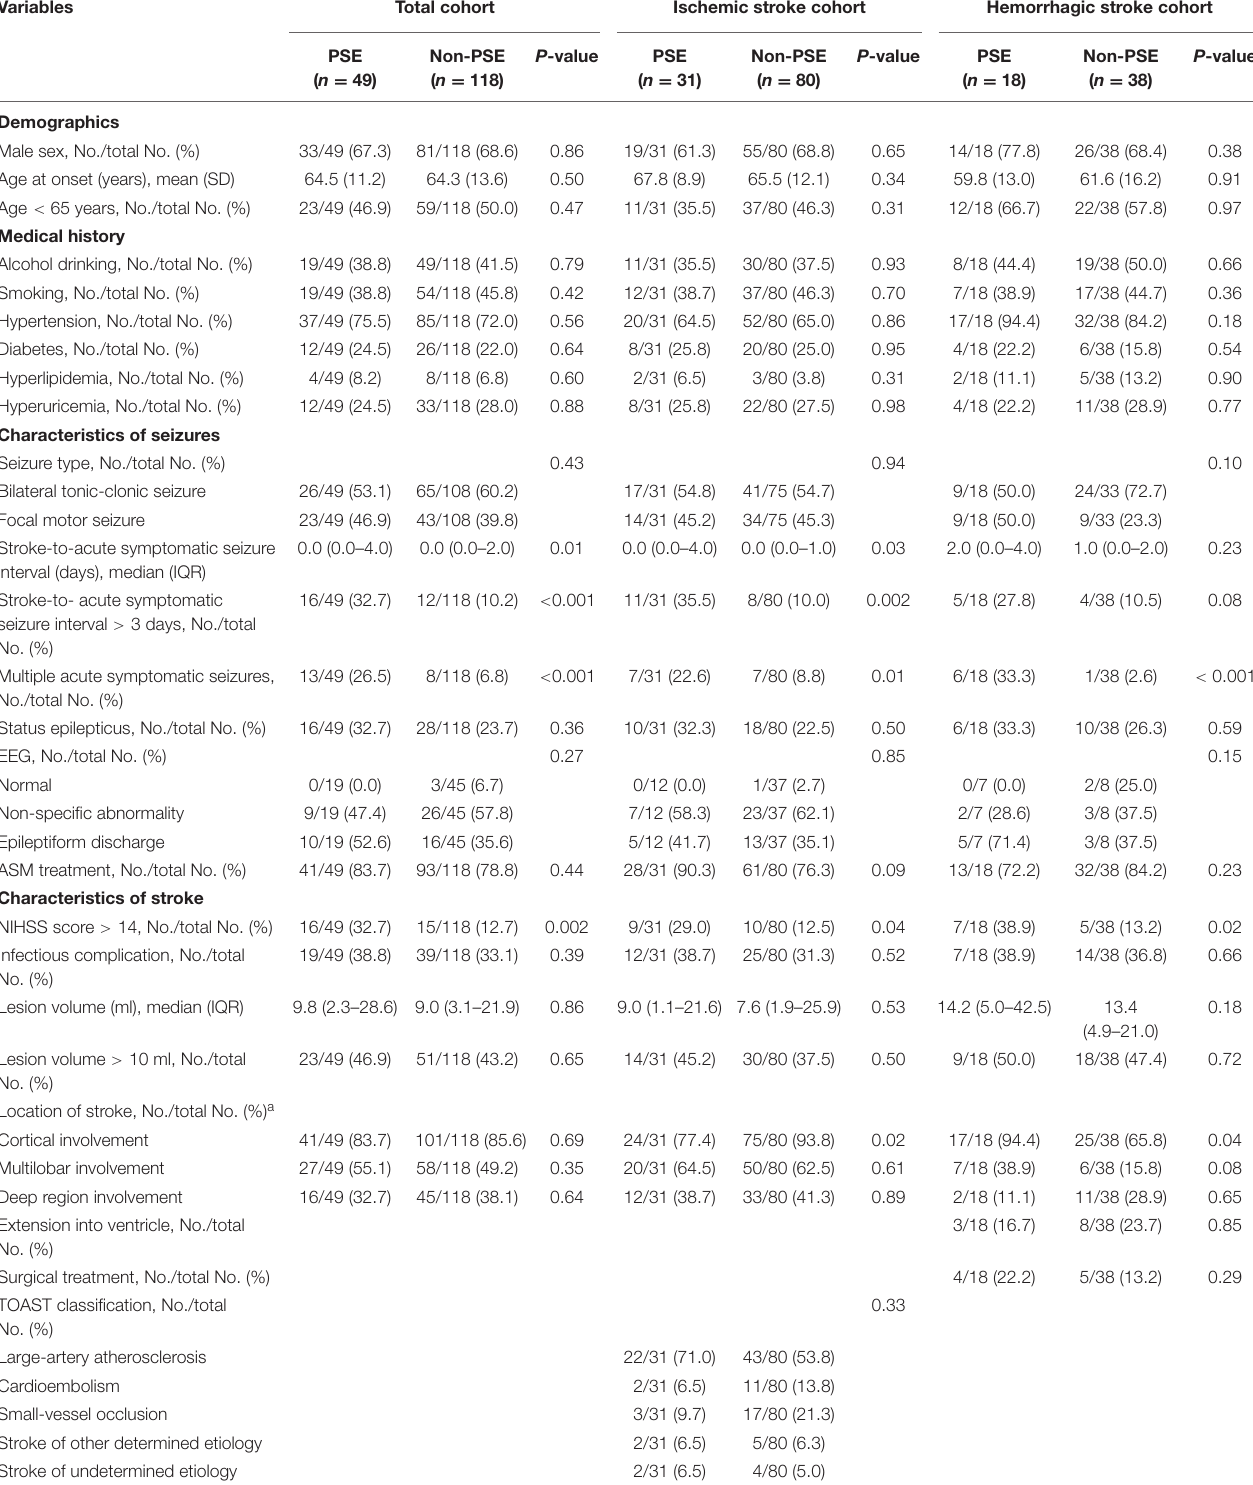
TABLE 3 | Univariable analysis of baseline characteristics associated with development of PSE.